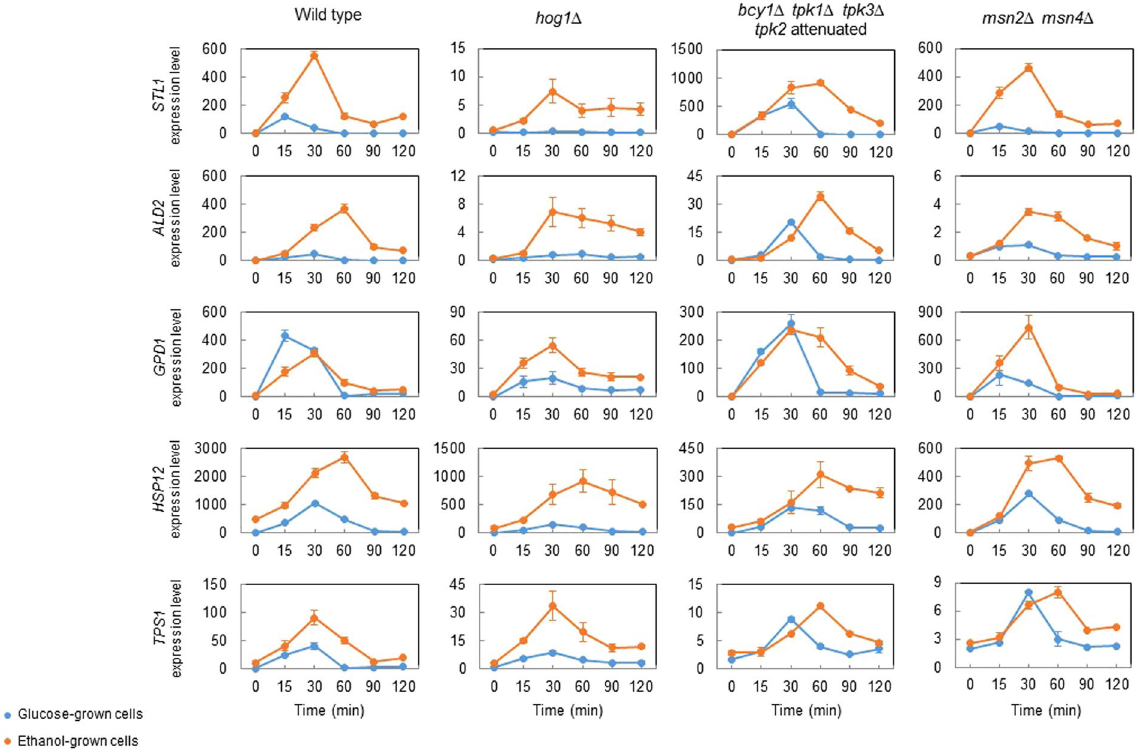
Figure 7. Gene expression monitored by qPCR. Cells in the W303-1A background were pregrown in complete YPE medium and shifted to YPE with 0.4 M NaCl at time 0 min. A wild type, a hog1 Δ mutant, a mutant with low constitutive PKA activity ( bcy1 Δ tpk1 Δ tpk2 w (attenuated) tpk3 Δ ) and a mutant lacking the transcription factors Msn2 and 4 ( msn2 Δ msn4 Δ ) were used. Note that different scales were used on the y-axis to document osmostress-induced gene expression even at different basal expression levels in the different